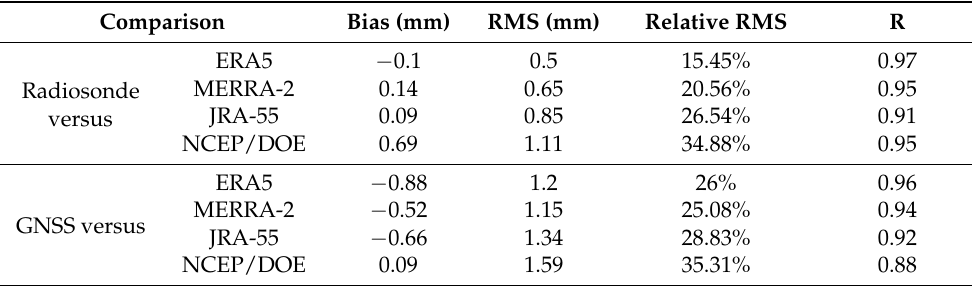
Table 3. Statistical results of the assessment of PWV derived from four reanalyses by radiosonde- and GNSS-derived PWV from 2001 to